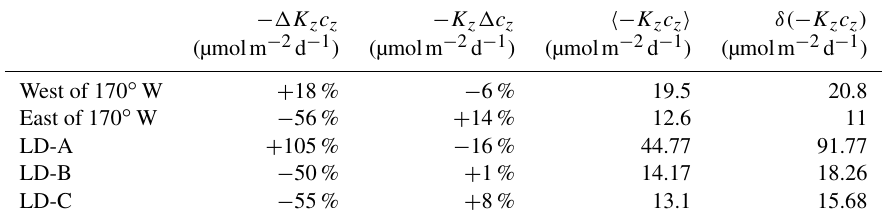
Figure 10. Longitude–depth sections of chlorophyll concentration (a) , K z (b) , nitrate concentration (c) , phosphate concentration (d) , nitrate turbulent diffusive flux (e) , and phosphate turbulent diffusive flux (f) . The top of the nitracline is shown with a magenta line, the depth of maximum chlorophyll concentration with a green line, and the euphotic zone depth with a dashed black line. The locations of the LD stations are shown with a vertical dashed line. The scales of the color bar of the nitrate and phosphate concentration and turbulent diffusive flux are set to allow a direct comparison of concentrations and fluxes against nutrient requirements for phytoplankton (Redfield proportion: N : P = 16 : 1). Table 5. Relative contributions to the flux variations of K z and c z depth-averaged over a 100m vertical layer defined from the top of the nitracline, west of 170 ◦ W and east of 170 ◦ W and at long-duration stations. The mean value and standard deviation are also